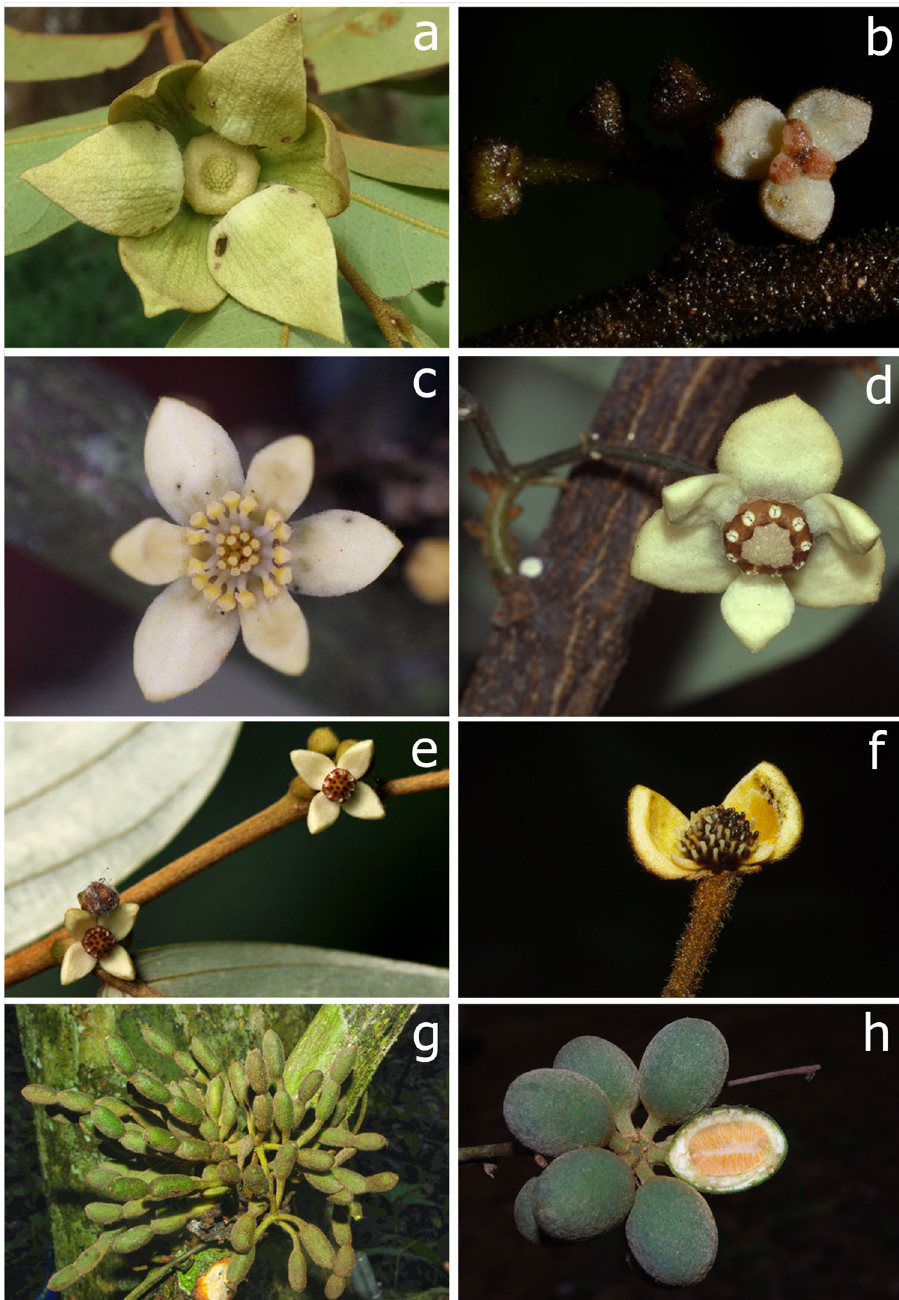
Figure 1. Flower morphology of outgroups ( a ) and flowers and fruits of Monanthotaxis ( b – h ). ( a ) Uvaria scabrida , flower showing many stamens and carpels; ( b ) Monanthotaxis bidaultii male flower showing three petals and three stamen; ( c ) Monanthotaxis couvreurii , flower showing basally fused stamens; ( d ) Monanthotaxis whytei , cauliflorous flower with nine hardly visible staminodes alternating with nine stamens; ( e ) flowers of Monanthotaxis poggei showing four petals and eight stamen, each in a single whorl; ( f , g ) Monanthotaxis diclina , female flower with one petal removed showing many carpels, and fruits showing multiple seeds per monocarp; ( h ) Monanthotaxis paniculata fruits with single seed per monocarp. — Photographs: ( a ) Paul H. Hoekstra, ( b ) Ehoarn Bidault; ( c , f – h ) Thomas L.P. Couvreur; ( d ) Lubbert Y.T. Westra; ( e ) Bart T.